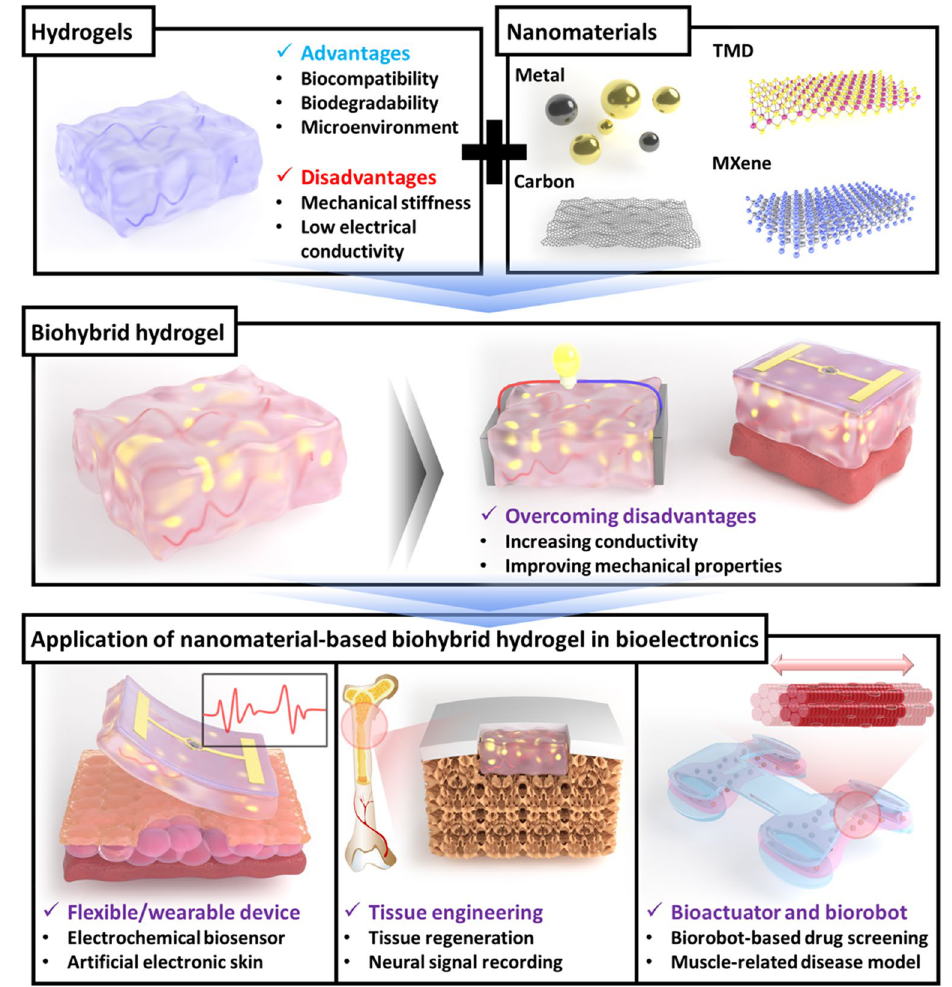
Fig. 1 Schematic diagram of nanomaterial‑based biohybrid hydrogel in bioelectronics to develop flexible/wearable bioelectronic device, tissue engineering, and